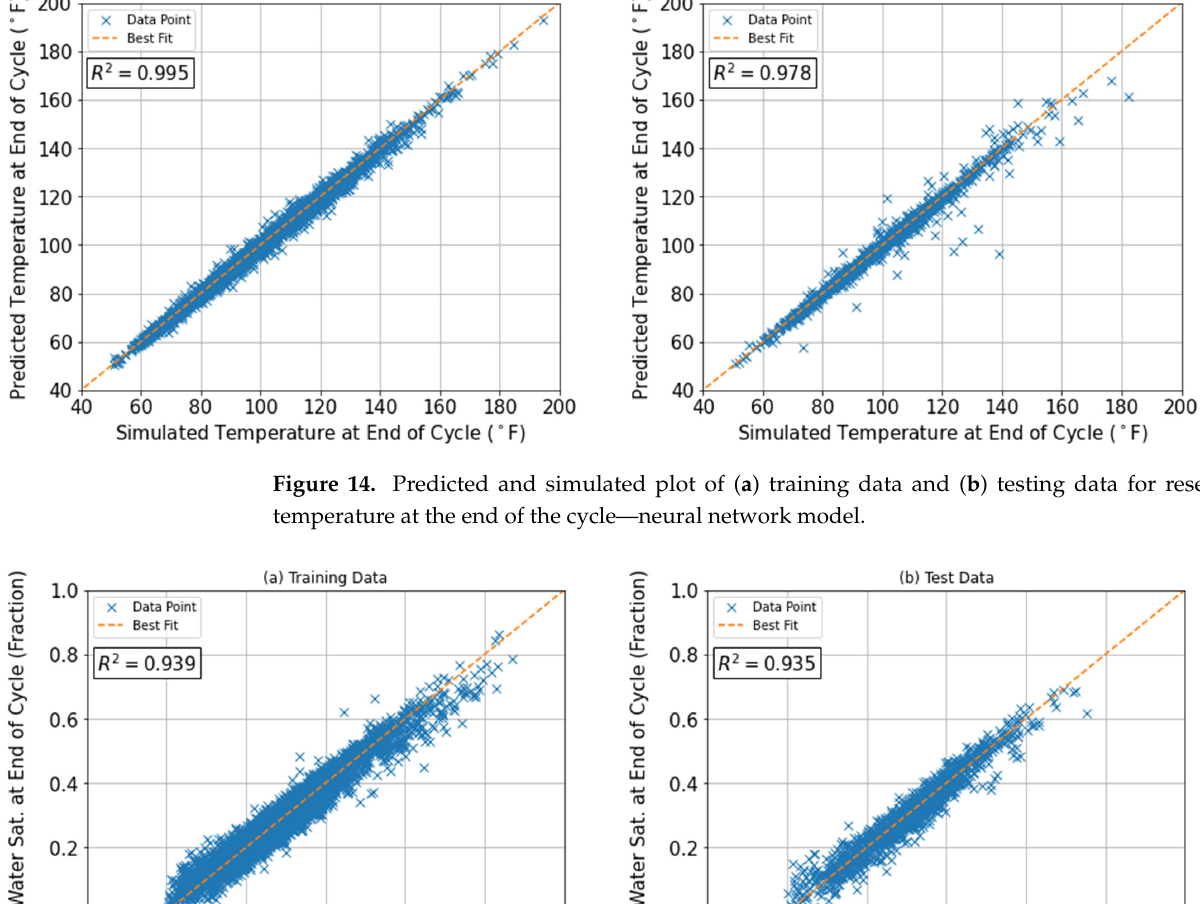
Figure 14. Predicted and simulated plot of ( a ) training data and ( b ) testing data for reservoir tem- perature at the end of the cycle—neural network model.